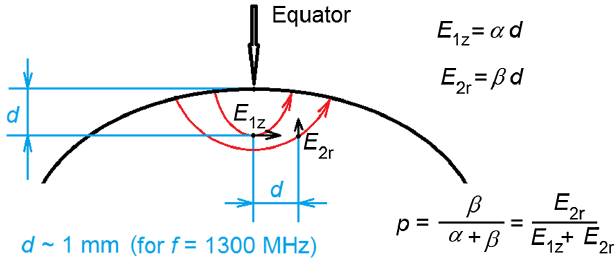
FIG. 13. Definition of the geometrical parameter p .